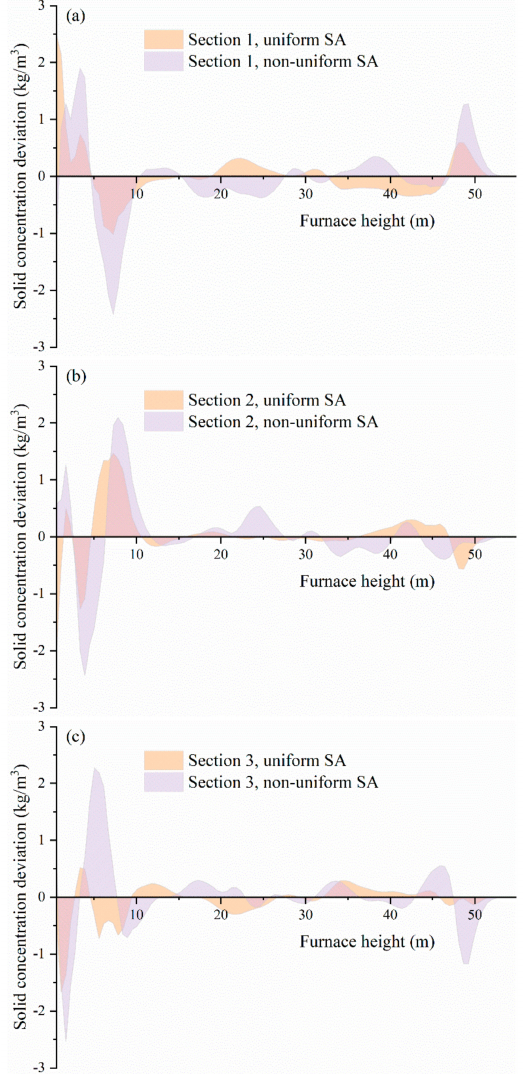
Figure 12. Influence of secondary air uniformity on the deviation of solid concentration along furnace height in Section 1, 2 and 3 (( a )—Section 1 ( b )—Section 2; ( c )—Section